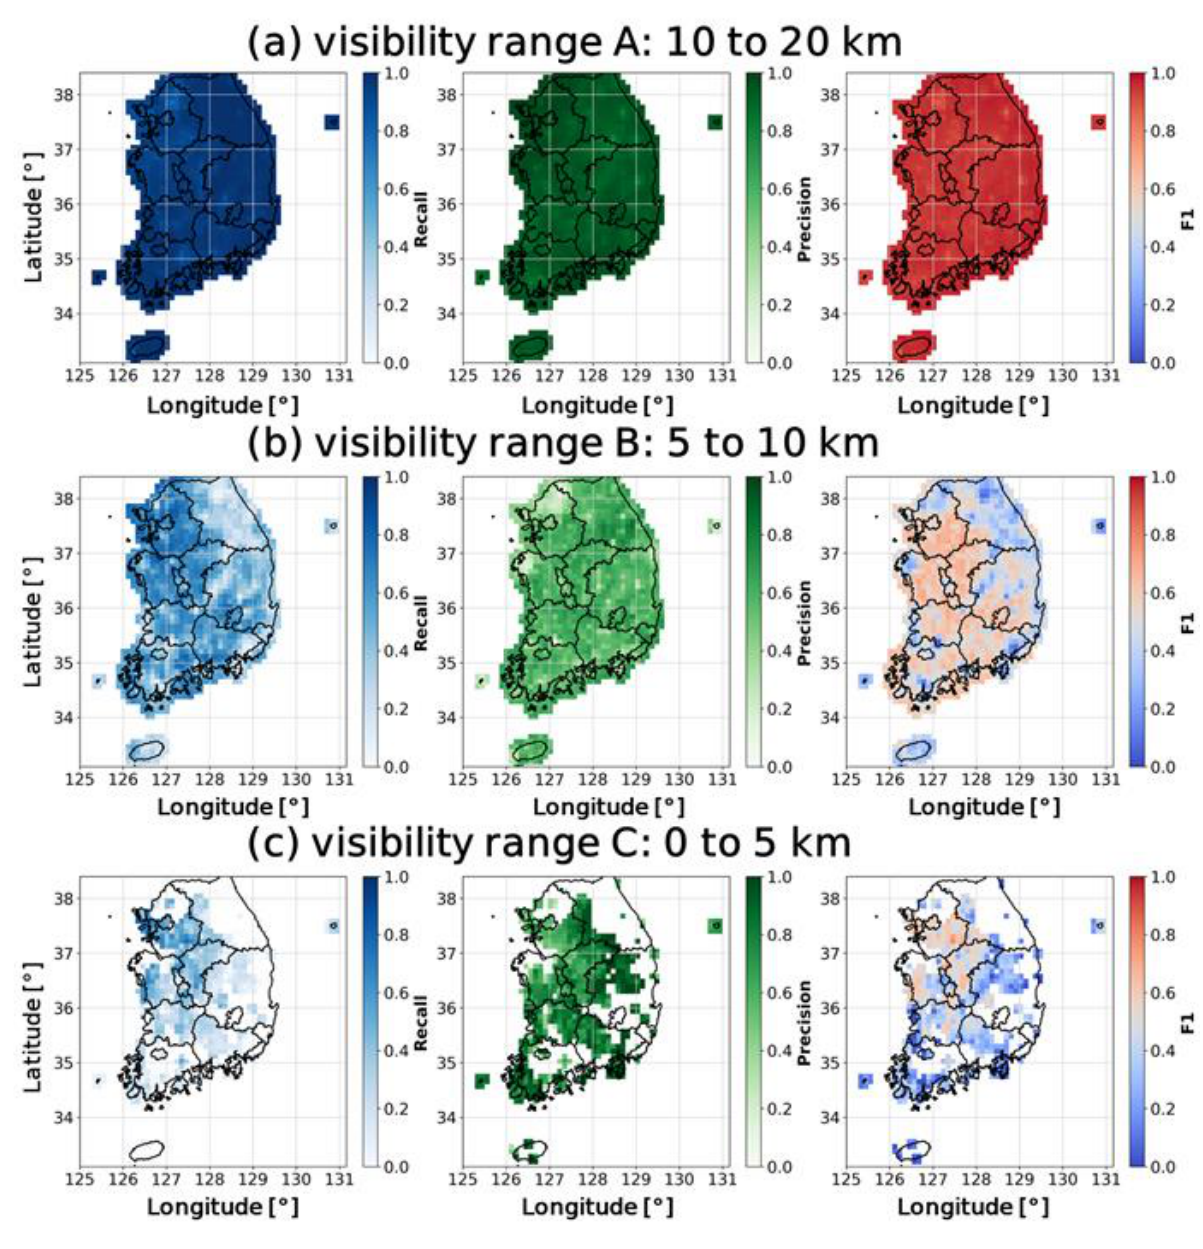
Figure 8. Recall, Precision, and F1 score of visibility estimation models in South Korea for three visibility ranges (( a ) 0 to 5 km, ( b ) 5 to 10 km, and ( c ) 10 to 20 km) for period from January to October 2021 (test set).